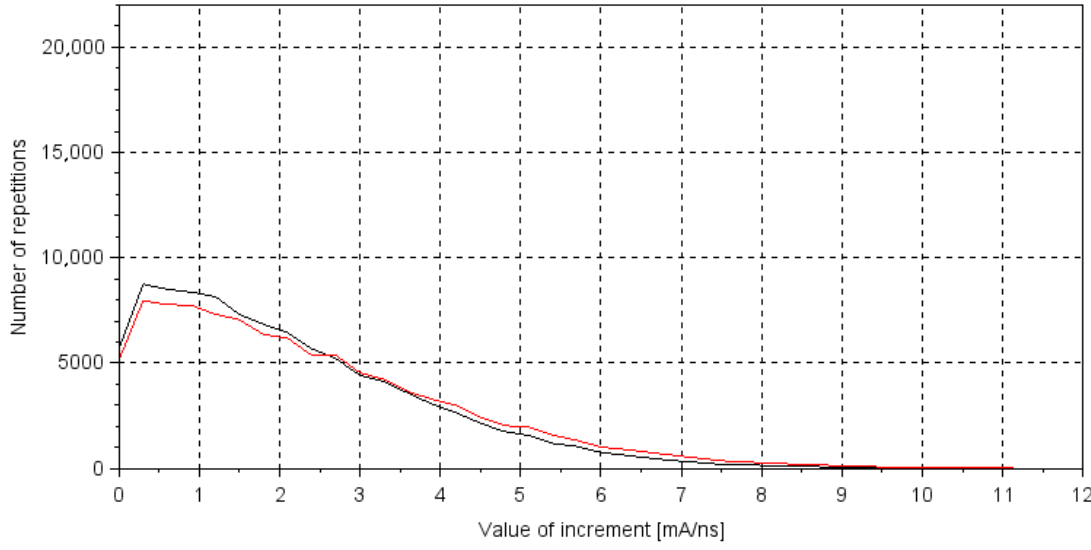
Figure 8. Figure showing 100 kpts decompositions of signals at different voltages, with 160 V (black) and 1.6 kV (red) (conditions: 1 mm gap between electrodes and current of 900 mA DC at each measurement).